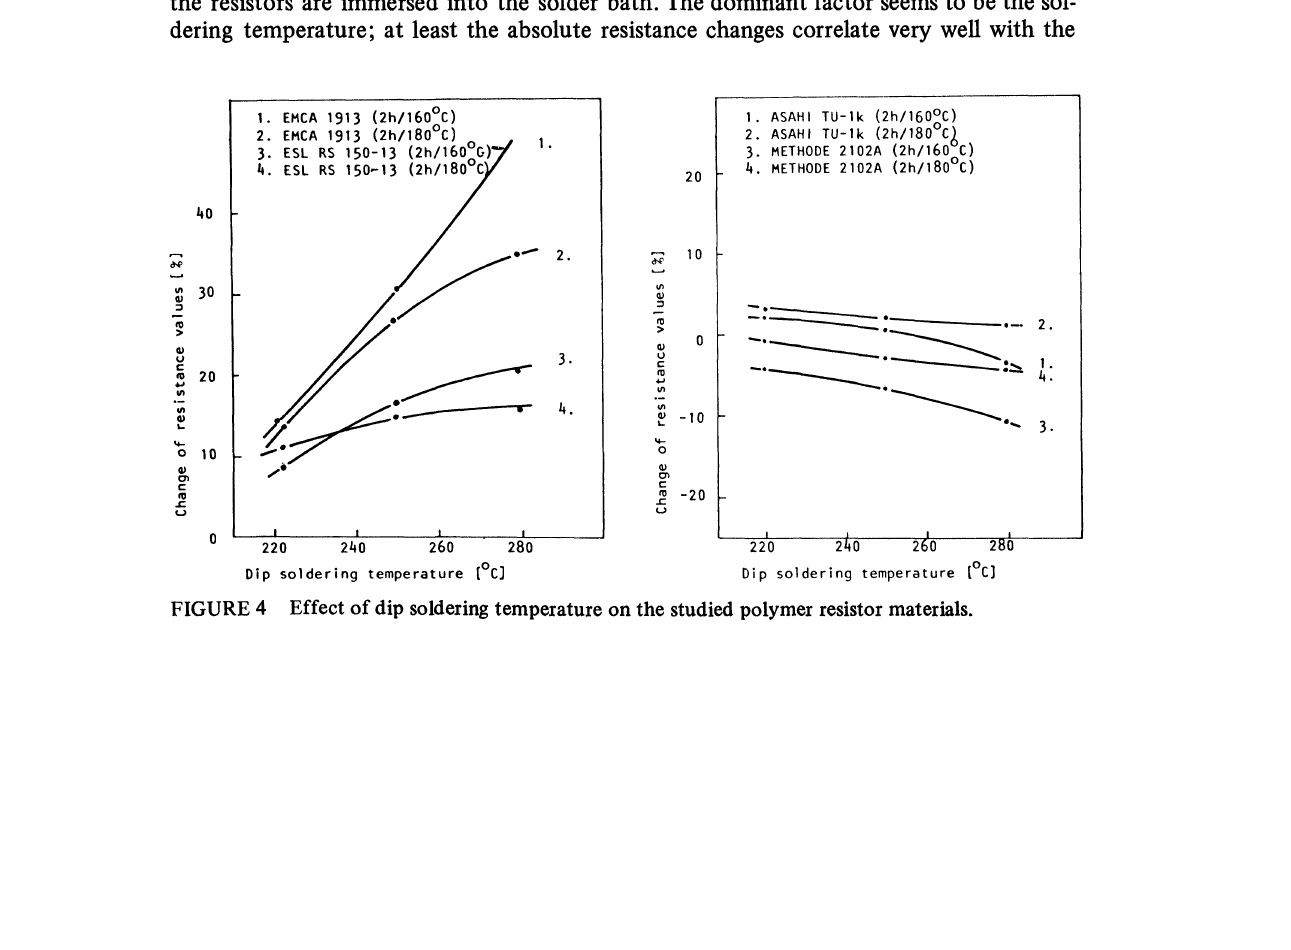
FIGURE 4 Effect of dip soldering temperature on the studied polymer resistor